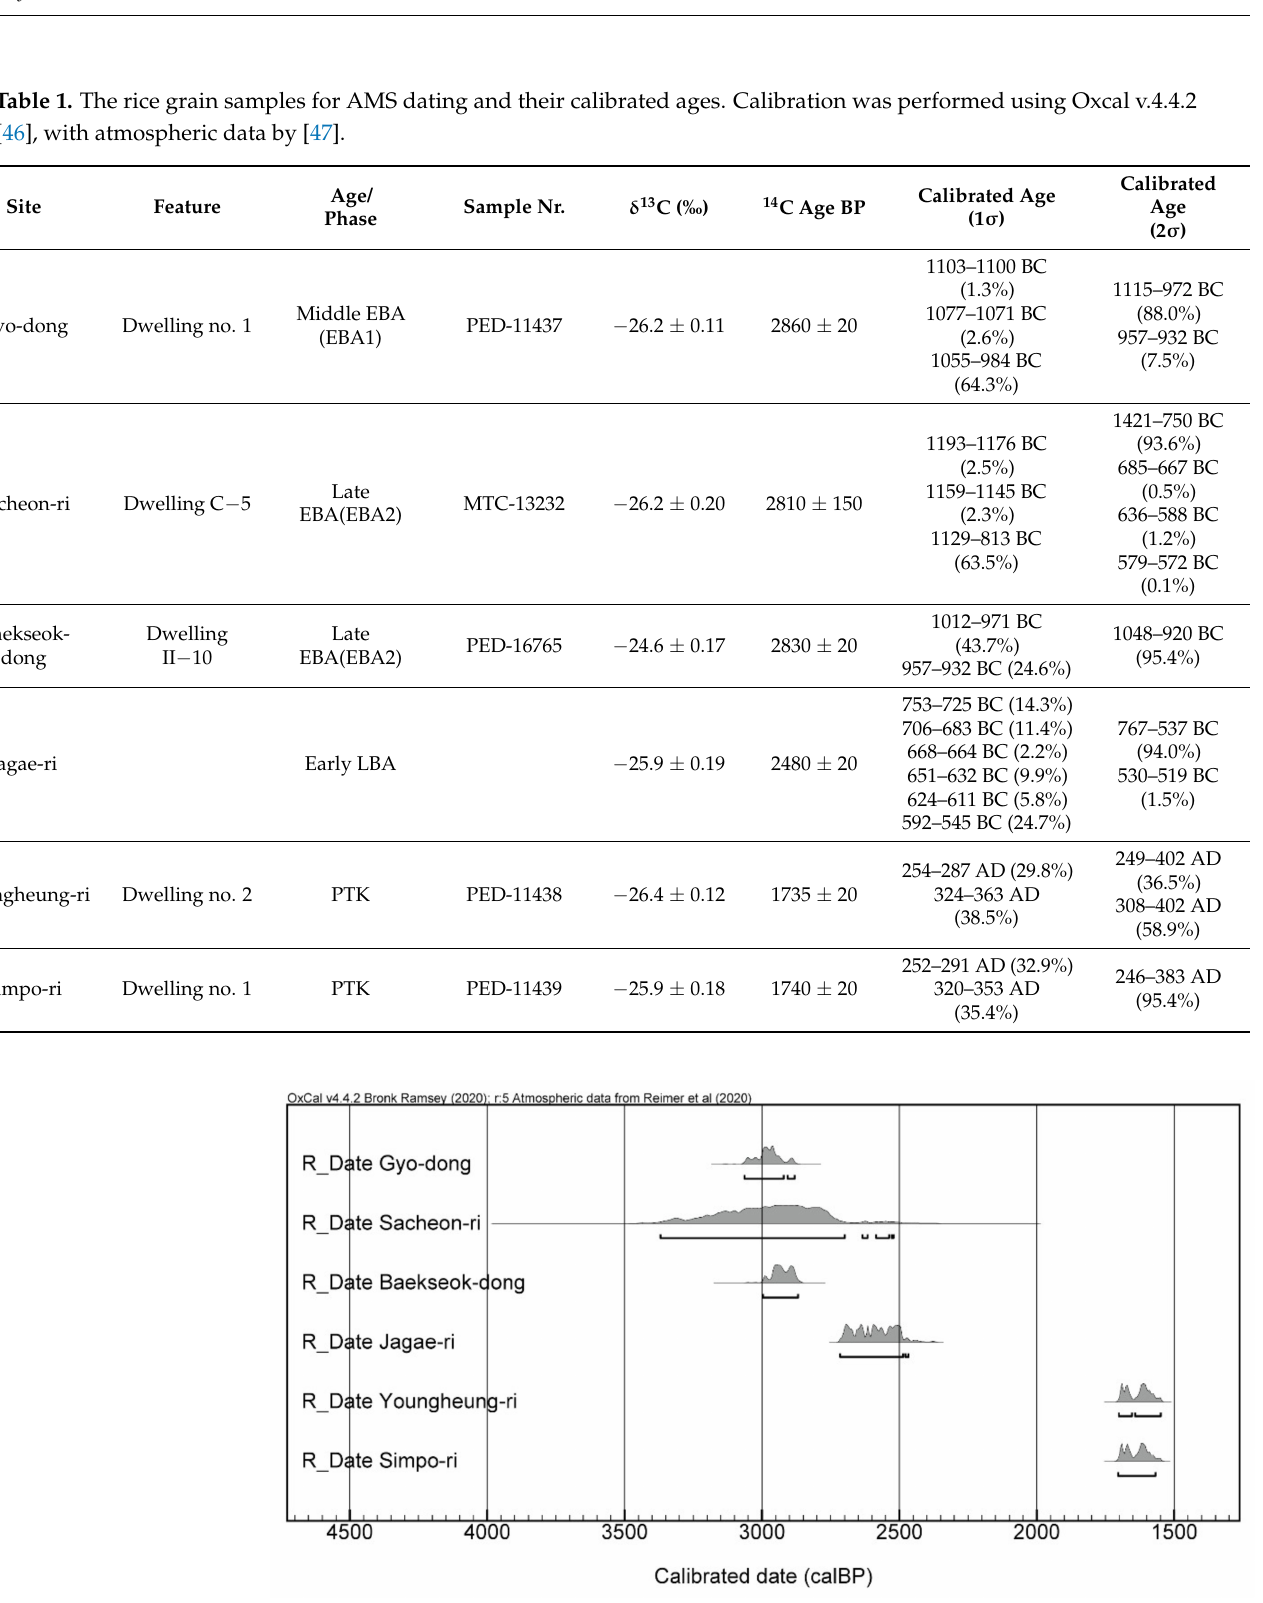
Figure 2. Calibrated ages (2 σ ) of radiocarbon dates of rice grains from the archaeological sites in Korea (see Table 1 for sample